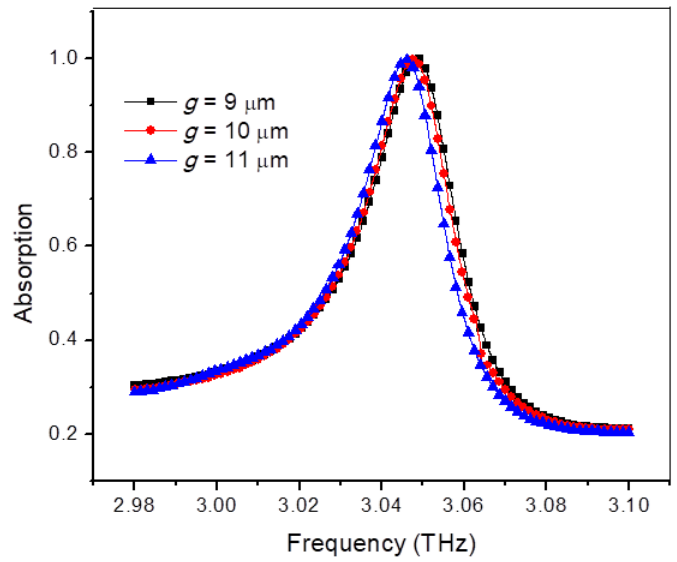
Figure 7. Absorption spectra obtained by varying the gap between the U-shaped strips.